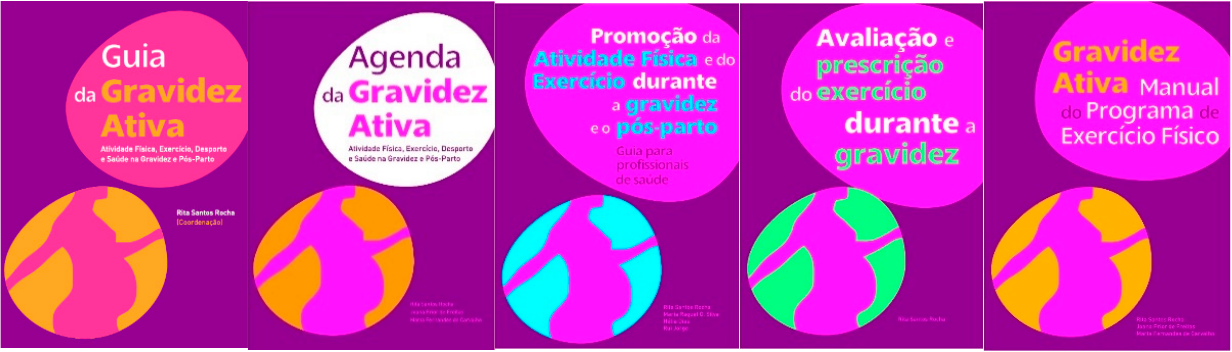
Figure 1. Layout of the educational materials produced with the support of IPDJ—Instituto Português do Desporto e da Juventude (Portuguese Institute of Sport and Youth).